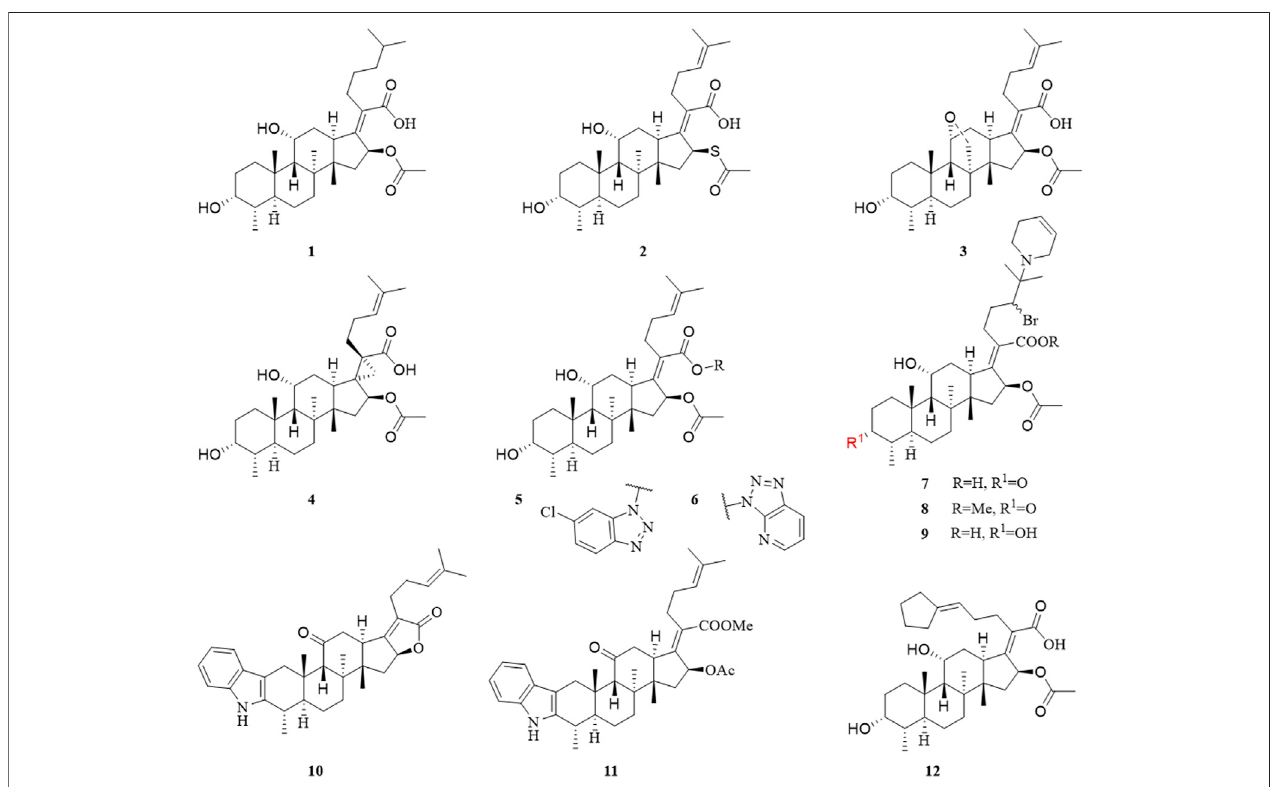
FIGURE 2 | Structural formulae of compounds 1 – 12